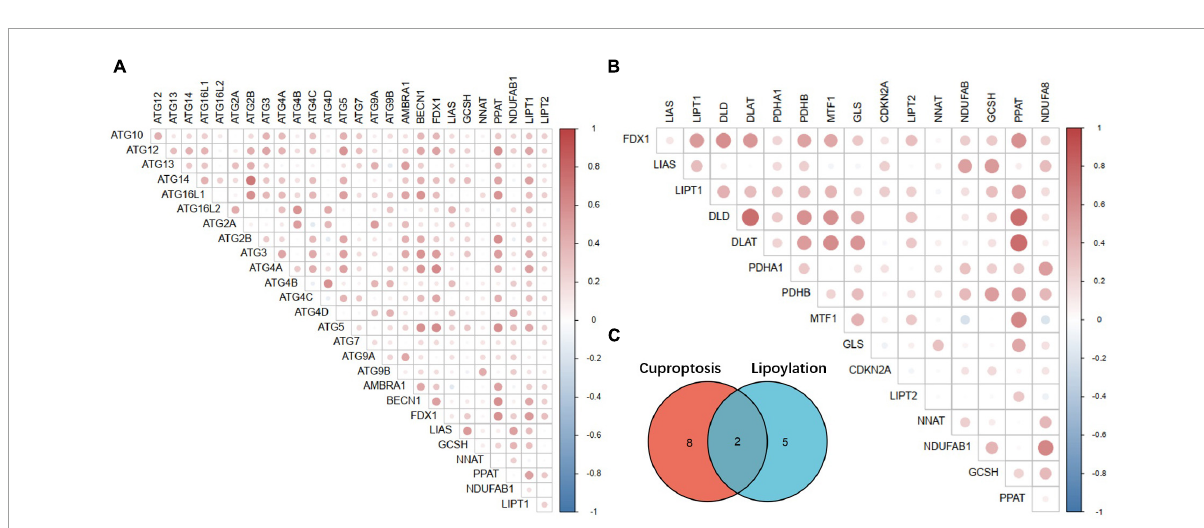
FIGURE10 Correlation analysis between key Cuproptosis genes, autophagy-related genes and lipoylation genes. (A) Correlation analysis between Fdx1-related Cuproptosis genes and autophagy-related genes. (B) Correlation analysis between Fdx1-related Cuproptosis genes and key genes of protein lipoylation. (C) Illustration of the intersection of identified Cuproptosis and protein lipoylation genes.